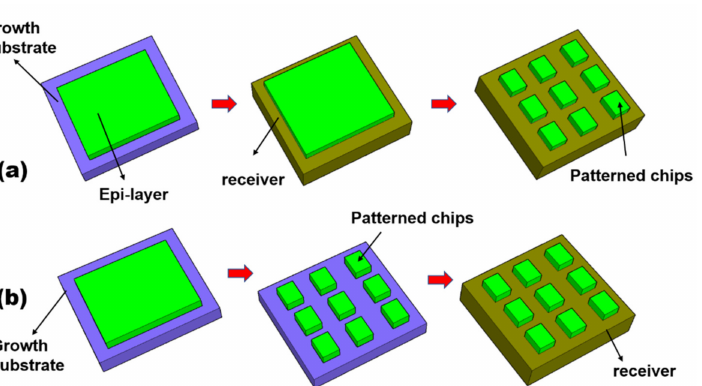
Figure 15. Sketches of the two methods for chip-level transfer by ELO. ( a ) “Layer-first” concept, where the epi-layer is first transferred to a receiving substrate by ELO. The transferred epi-layer is then patterned into functional chips. ( b ) “Chip-first” concept, where the epi-layer is first patterned into function chips, and then they are transferred to a receiver substrate by